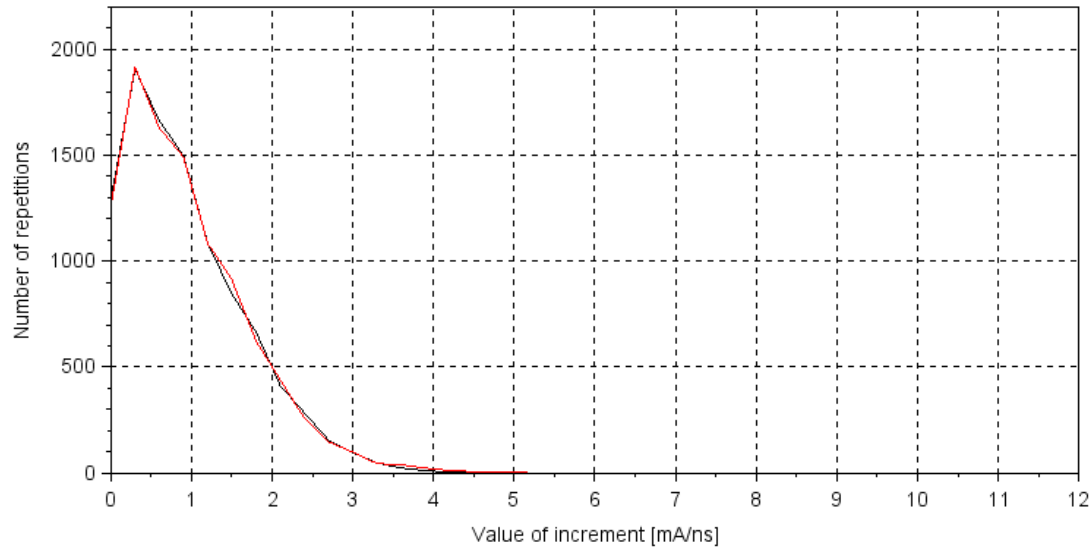
Figure 11. Figure showing 10 kpts decompositions of signals with no arc (conditions: shorted spark gap and current of 500 mA DC at each measurement).